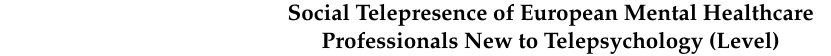
Table 3. Econometric model predicting social telepresence in telepsychology and the characteristics of new European mental health professional